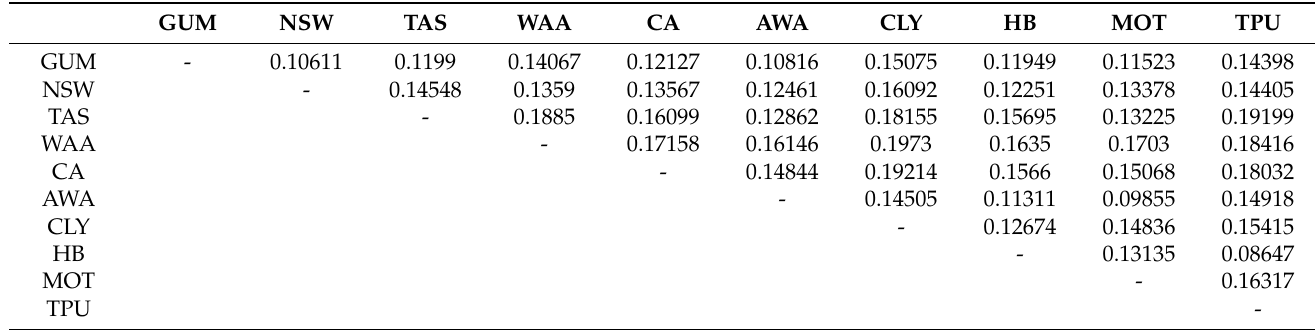
Table 5. Average FST across the whole genome of Epiphyas postvittana (calculated as average of all gene and intergenic FSTs). For population abbreviation, see Table 4.